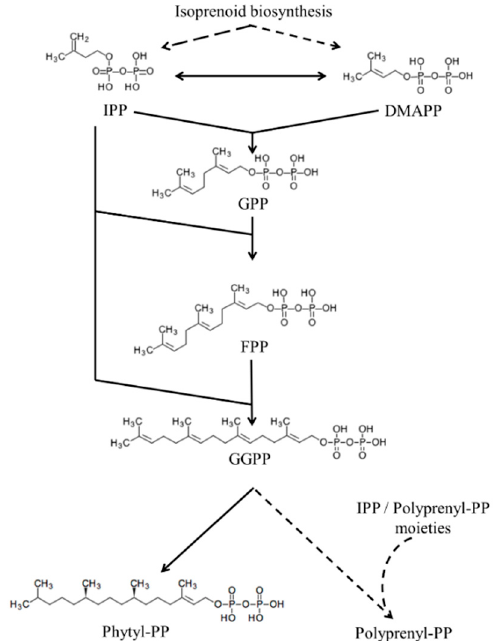
Figure 4. Isoprenic chain elongation / reduction. Isoprenic chain chemical structures and its elongation / reduction pathways. Continuous arrows indicate a single enzymatic step and discontinuous arrows indicate several enzymatic steps. Enzymatic steps are better described in the text. Structures sourced from Kyoto Encyclopedia of Genes and Genomes database [87].